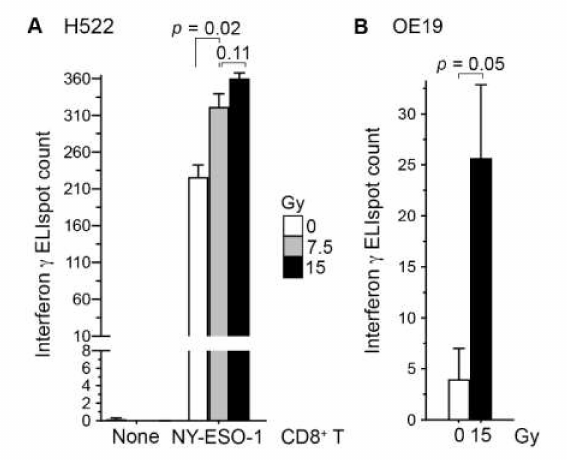
Figure 1. Irradiation of cancer cells enhanced their recognition by antigen-specific CD8 + T cells. Human H522 lung ( A ) or OE19 esophageal ( B ) adenocarcinoma cells were irradiated with one dose of 7.5 or 15 Gy X-rays or left untreated (0 Gy). Three days later, adherent cells were collected and co-cultured in triplicate at a 5:1 ratio with or without NY-ESO-1-specific human CD8 + T cells on an ELISpot plate for detecting interferon- γ -producing cells after a day. The mean and its standard error are plotted, and p values in standard t tests are